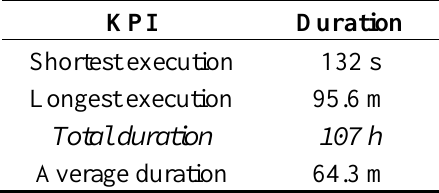
Table 15. KPIs, by using single-valued parameters, for 100